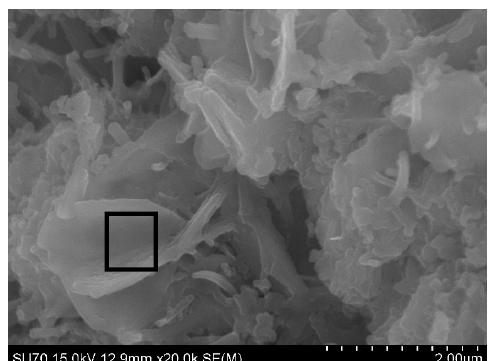
Figure 6. ( a , b ) SEM micrograph for 10_NCM mortar, ( c ) EDS spectrum from zone identified in ( b ).